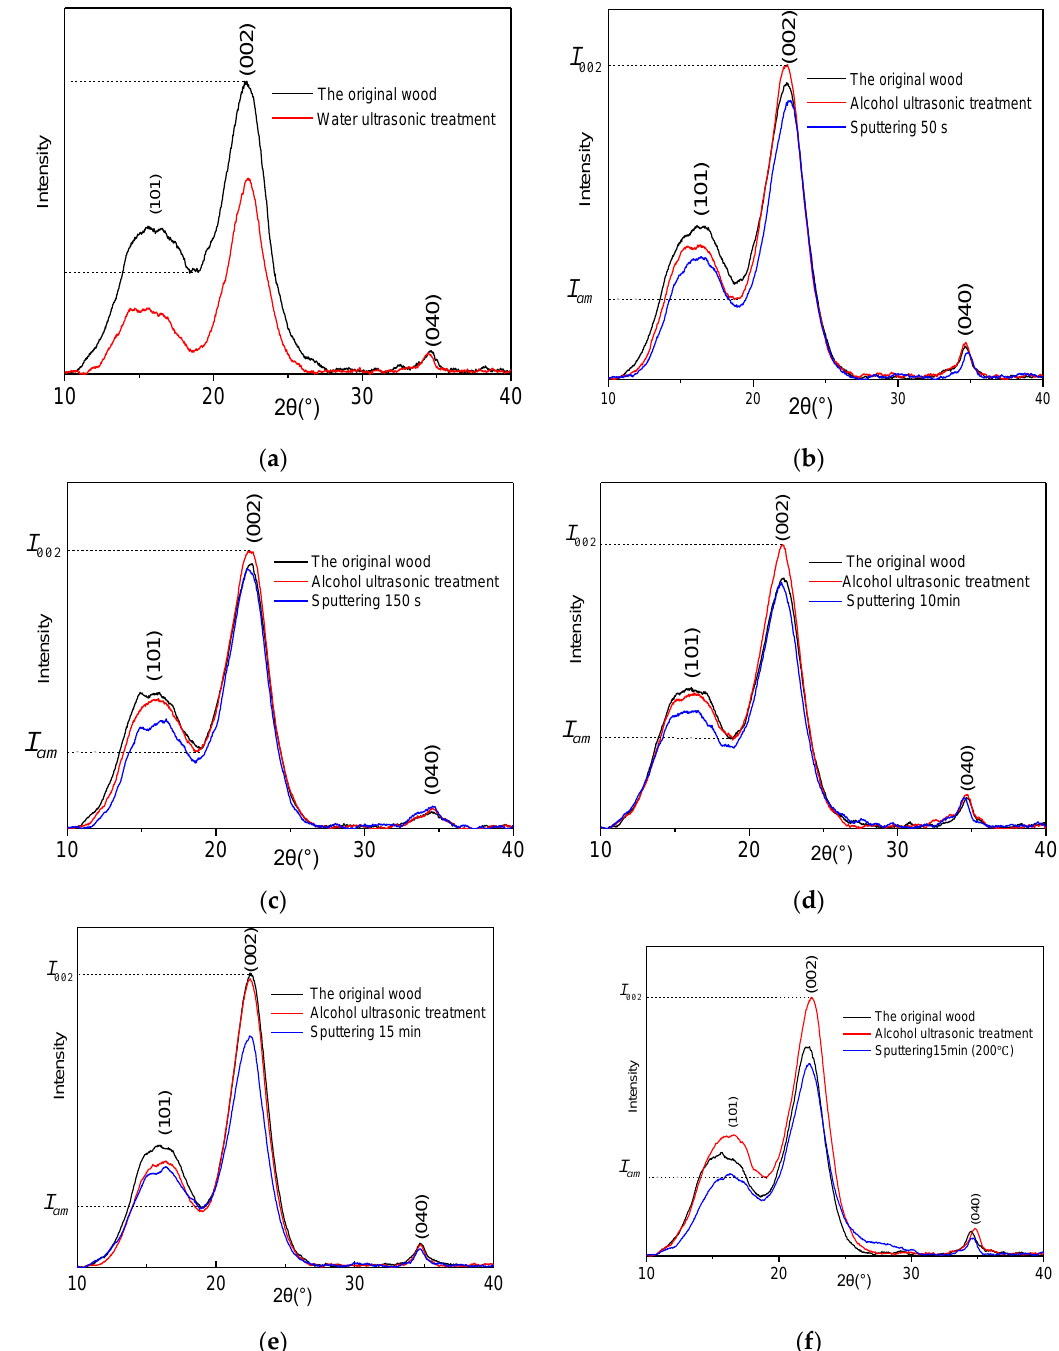
Figure 3. XRD map of wood veneer under different treatments in the range of 10° to 40°, (a) Ultrasonic treatment with water; (b) Magnetron sputtering for 50 s; (c) Magnetron sputtering for 150 treatment with water; ( b ) Magnetron sputtering for 50 s; ( c ) Magnetron sputtering for 150 s; s; (d) Magnetron sputtering for 10 min; (e) Magnetron sputtering for 15 min; (f) Magnetron ( d ) Magnetron sputtering for 10 min; ( e ) Magnetron sputtering for 15 min; ( f ) Magnetron sputtering for sputtering for 15 min (200 °C). 15 min (200 ◦